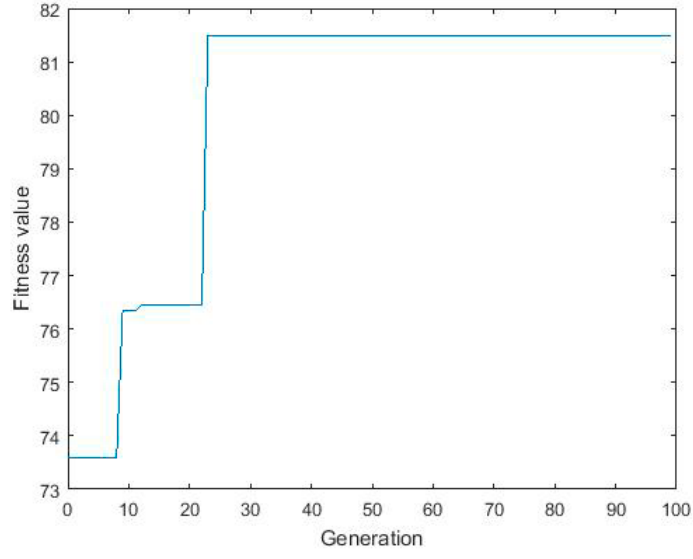
Figure 6. Evolvement of fitness with 100 generations.